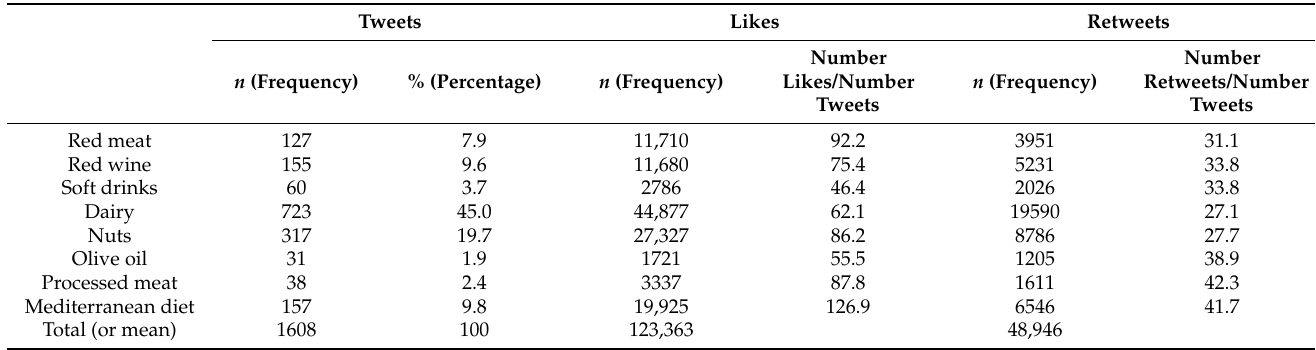
Table 1. Number of tweets posted from 2009 to 2019 by 25 major US media outlets about the Mediterranean diet and the likes and retweets generated by Twitter users. The percentages (%) are calculated with respect to the total number of